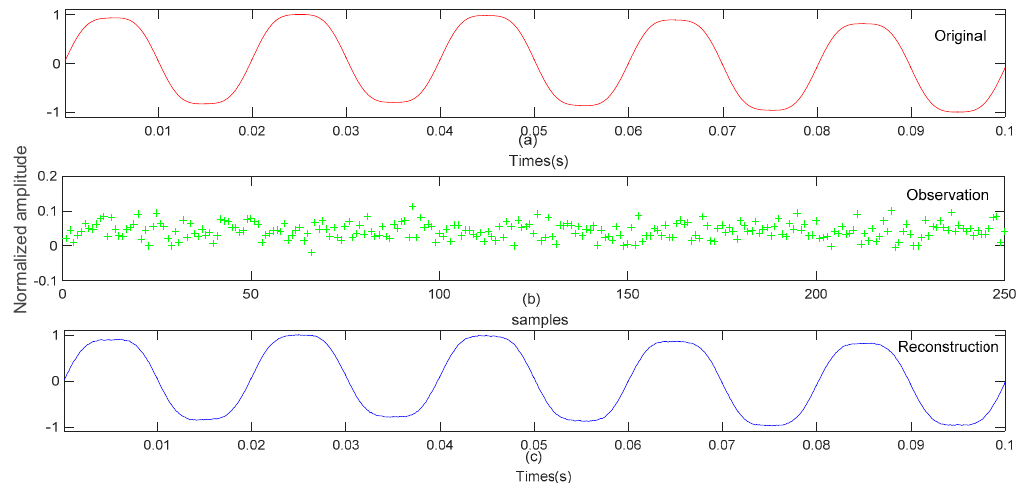
Figure 11. Application in power quality signal compressing and reconstructing with our proposed method.